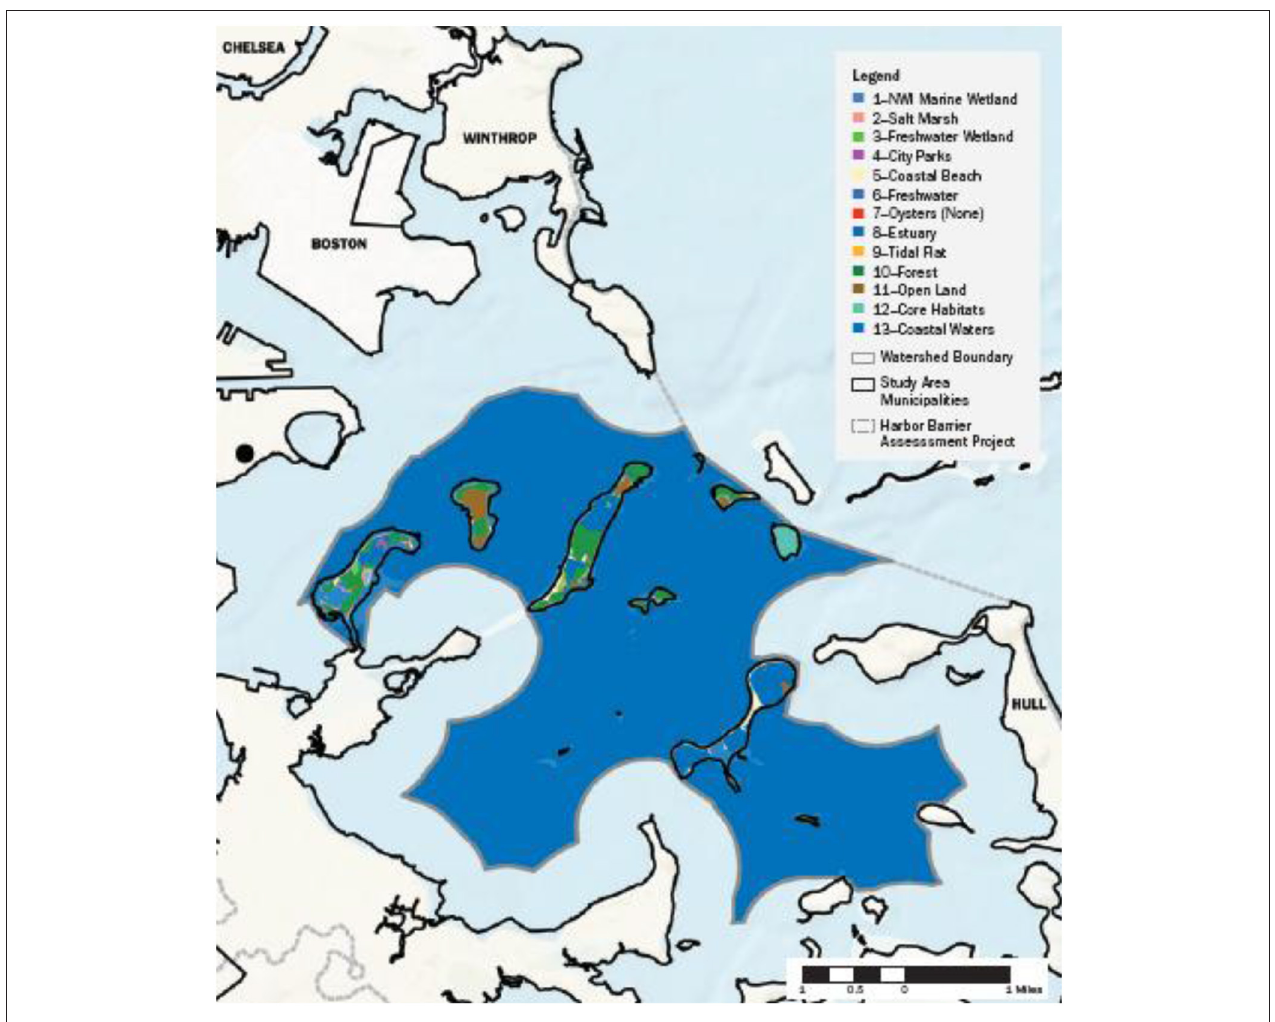
FIGURE 6 | Harbor Islands.